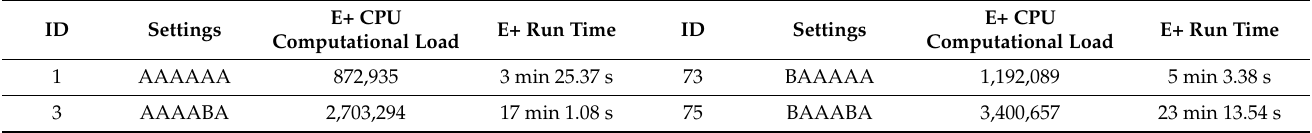
Table A1. Model specification and E+ simulation